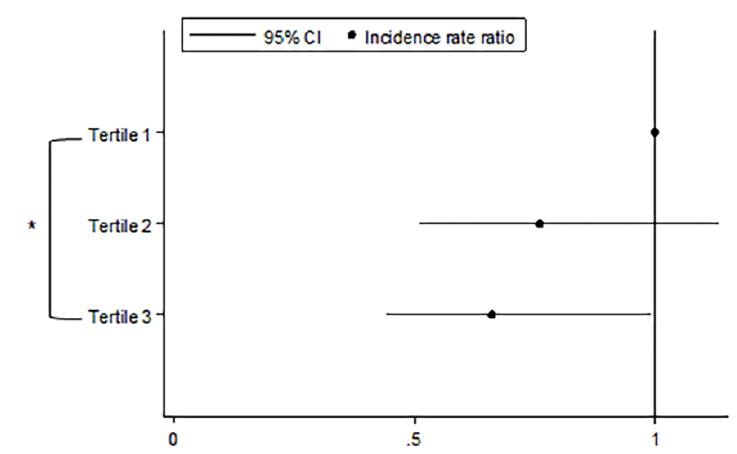
Figure 4. Comparison of the incidence rate of acute exacerbation according to annual rates of decline in Kco.